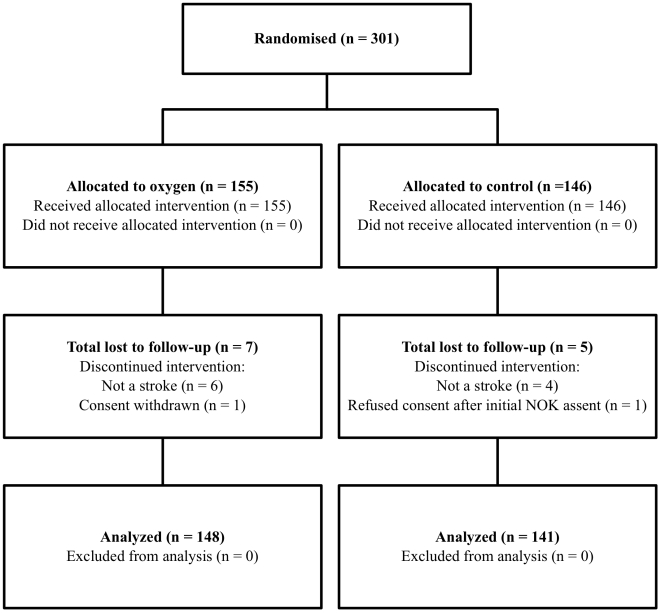
Consort diagram illustrating the flow of participants through the
study.NOK: Next of Kin.